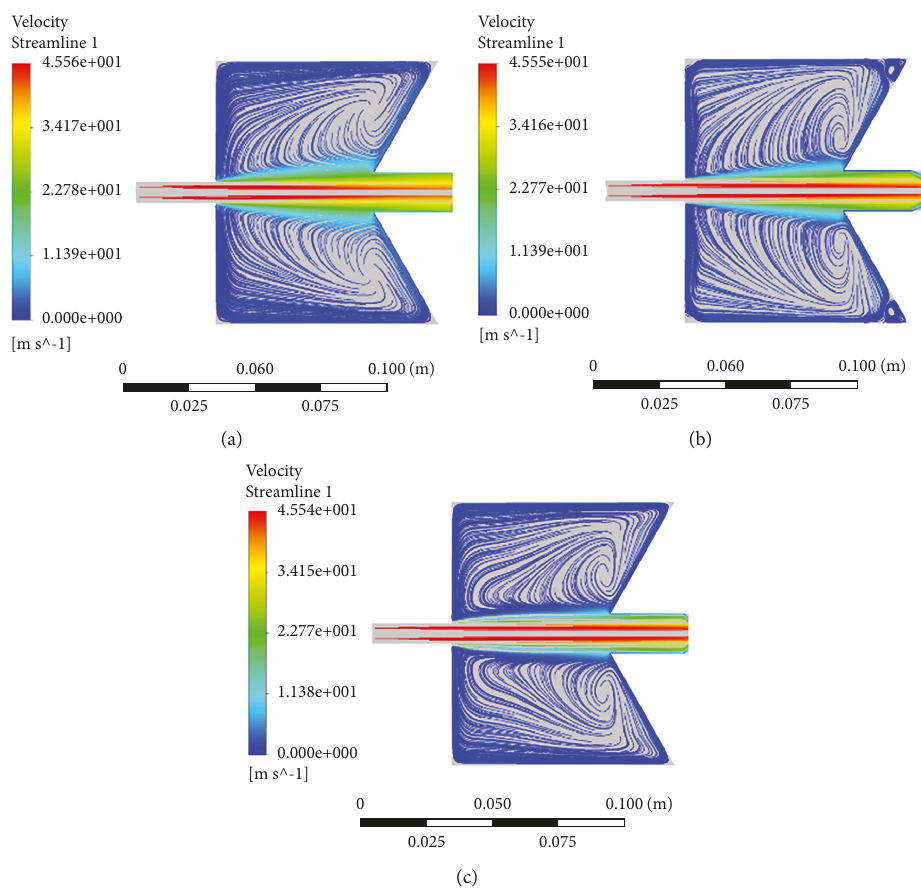
Figure 1: Velocity streamlines of the k-ε turbulence model. (a) The standard k-ε turbulence model. (b) The RNG k-ε turbulence model. (c) The realizable k-ε turbulence